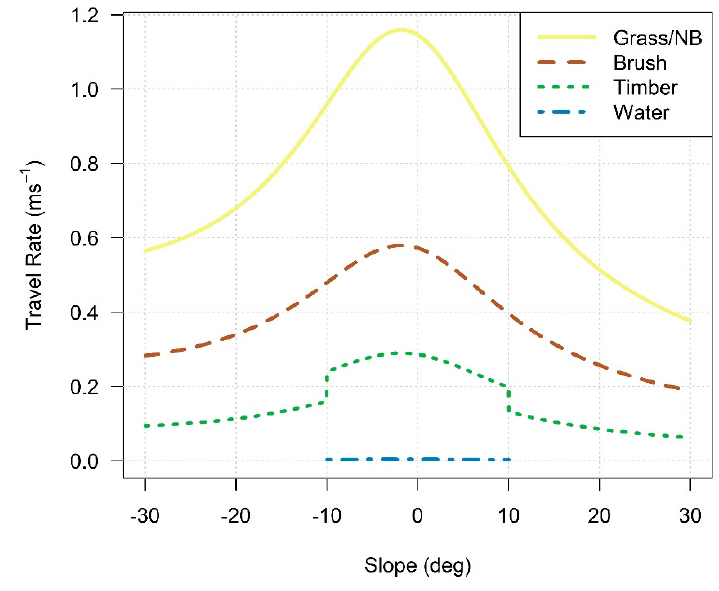
Figure 2. The e ff ects of terrain slope on pedestrian travel rates by WFDSS land cover Figure 2. The effects of terrain slope on pedestrian travel rates by WFDSS land cover class.